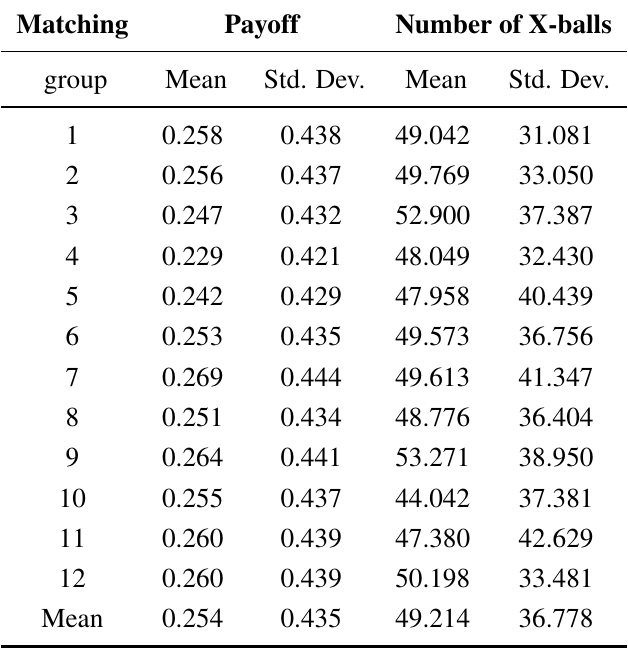
Table 2. Payoffs and mixed strategies at the matching group level.